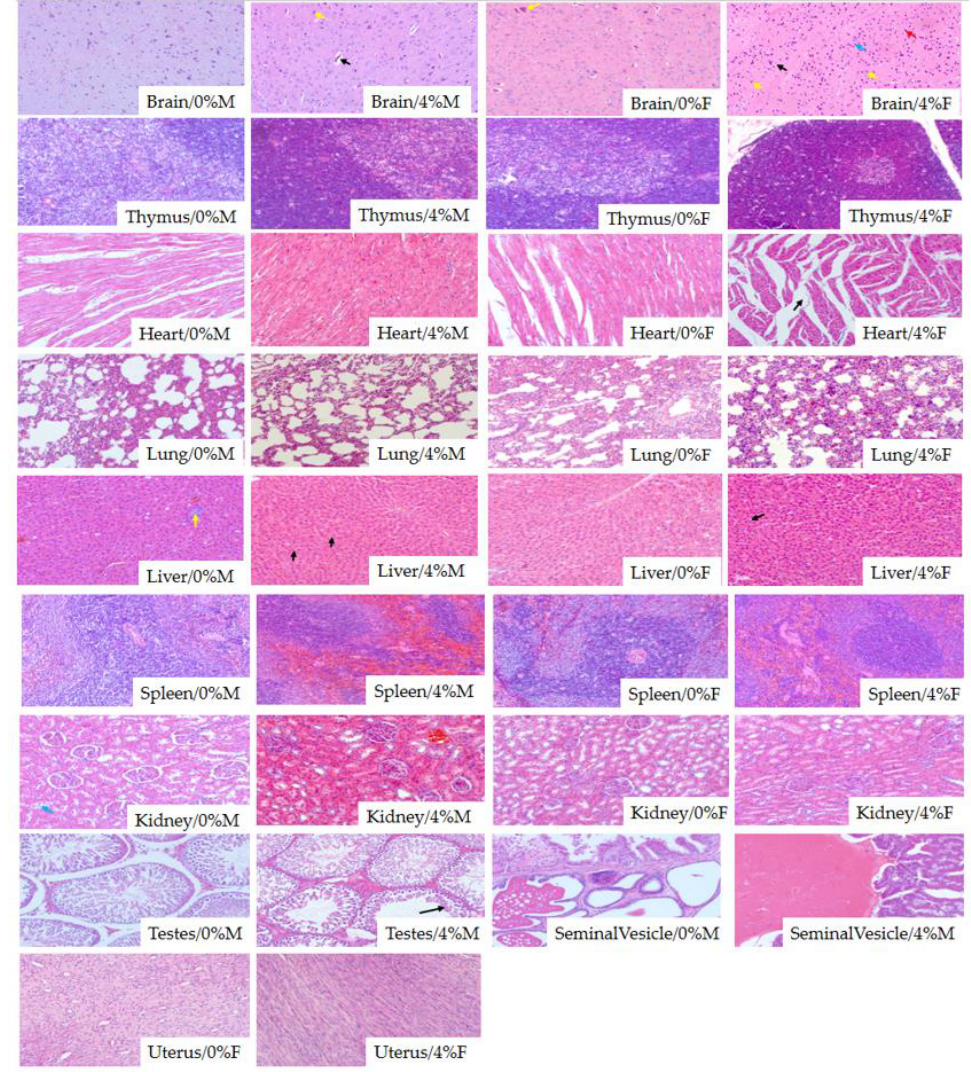
Figure 5. Microscopic examination results of organs for rats in the control and 4% groups. The values 0%, 4% represent daily intake of 0% ( w / w , control), 4% ( w / w , high dose) of freeze-dried PWPC-GSH powder. M and F represent male and female rats, respectively. For pictures of brain, black arrows represent vascular endothelium, yellow arrows represent the nucleus, red arrow are neurons and blue arrow are pyramidal cells. For picture of heart, black arrow represents the gap of cardiac muscle fiber bundle. For picture of liver, black arrows represent prototype vacuoles with regular shapes and yellow arrow represent red blood cells. For picture of testes, black arrows represent sperm cells.